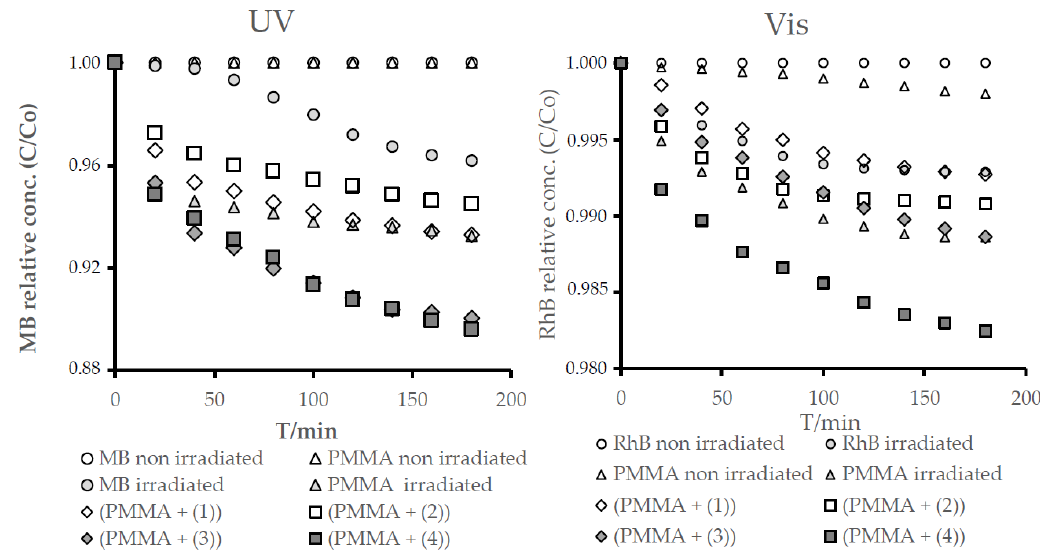
Figure 7. Changes in the concentrations of the methylene blue (MB) and Rhodamine B (RhB) solutions as a function of time for the respective composite materials irradiated with UV and Vis light. Table 5. Organic dye decolorization percentages and ∆ A 180 parameters for the studied reactions in relation to the composites.